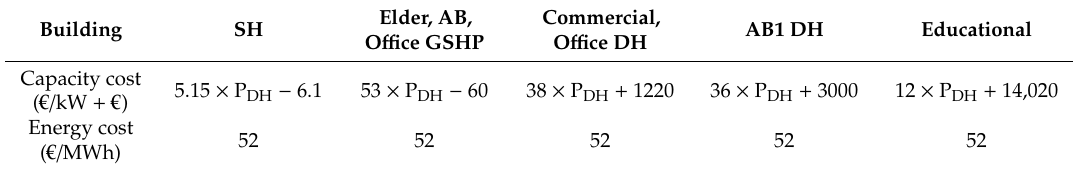
Table 4. District heating costs for di ff erent building types. P DH is the annual peak district heating power demand. Capacity costs are annual